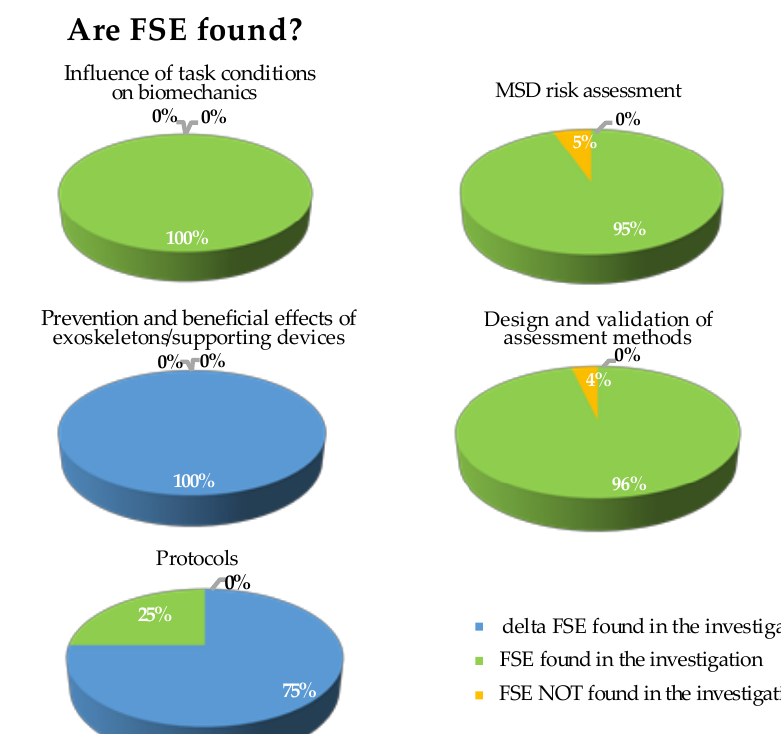
Figure 2. Main findings on FSE. For each category, papers were classified based on the main findings related to FSE. Papers showing differential effects of ergonomic interventions or supporting devices on FSE were classified in blue; papers that found FSE were classified in green; papers that measured but did not find FSE were classified in yellow.